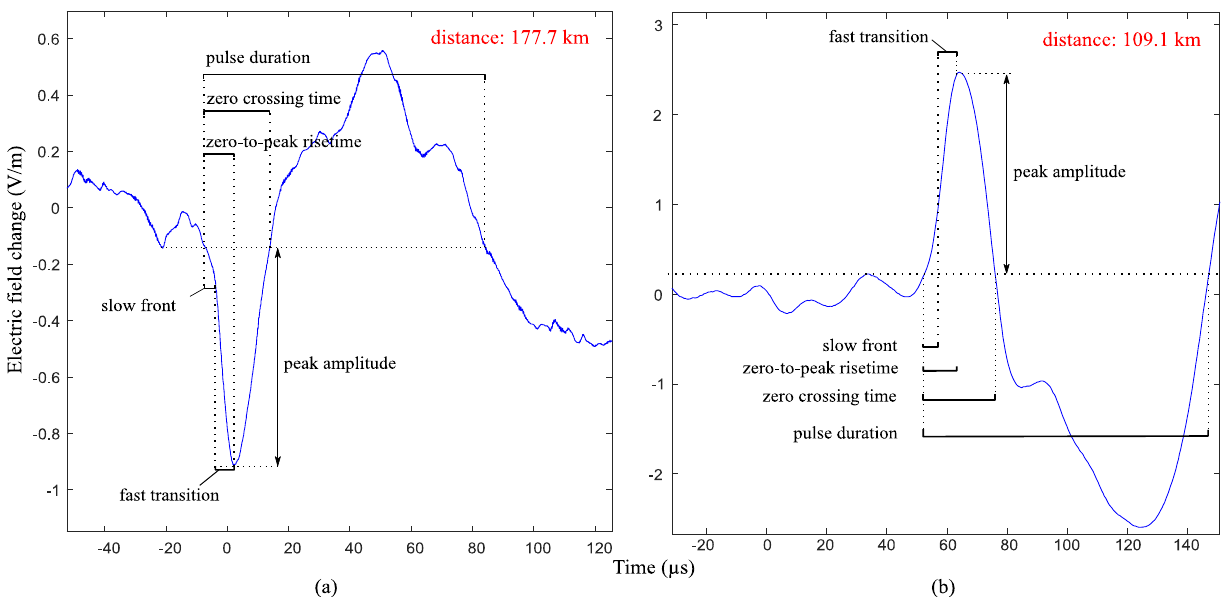
Figure 1. The characteristics of a return stroke for ( a ) a positive (+CG) flash detected at 177.7 km, and ( b ) a negative ( − CG) flash detected at 109.1 km, from measurement station, respectively. The waveforms are plotted based on atmospheric electricity sign convention.